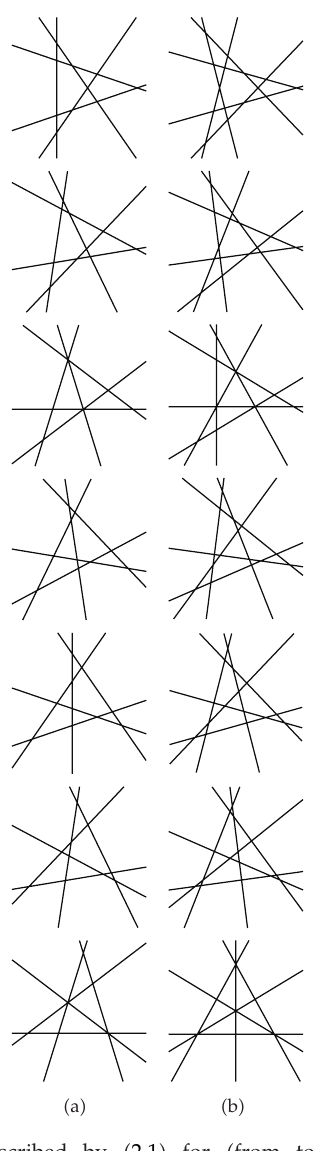
Figure 1: Line configurations described by (cid:6) 2.1 (cid:7) for (cid:6) from top to bottom (cid:7) (cid:6) a (cid:7) d (cid:8) 5; n (cid:8) 0 (cid:6)Σ 1 (cid:7) , 1 , 2 (cid:6) S B (cid:7) , 3 , 4 (cid:6)Σ 1 (cid:7) , 5 , 6 (cid:6) S B (cid:7) and (cid:6) b (cid:7) d (cid:8) 6; n (cid:8) 0 (cid:6)Σ 1 (cid:7) , 1 , 2 (cid:6) S C (cid:7) , 3 , 4 (cid:6)Σ 2 (cid:7) , 5 , 6 (cid:6) S A (cid:7) .